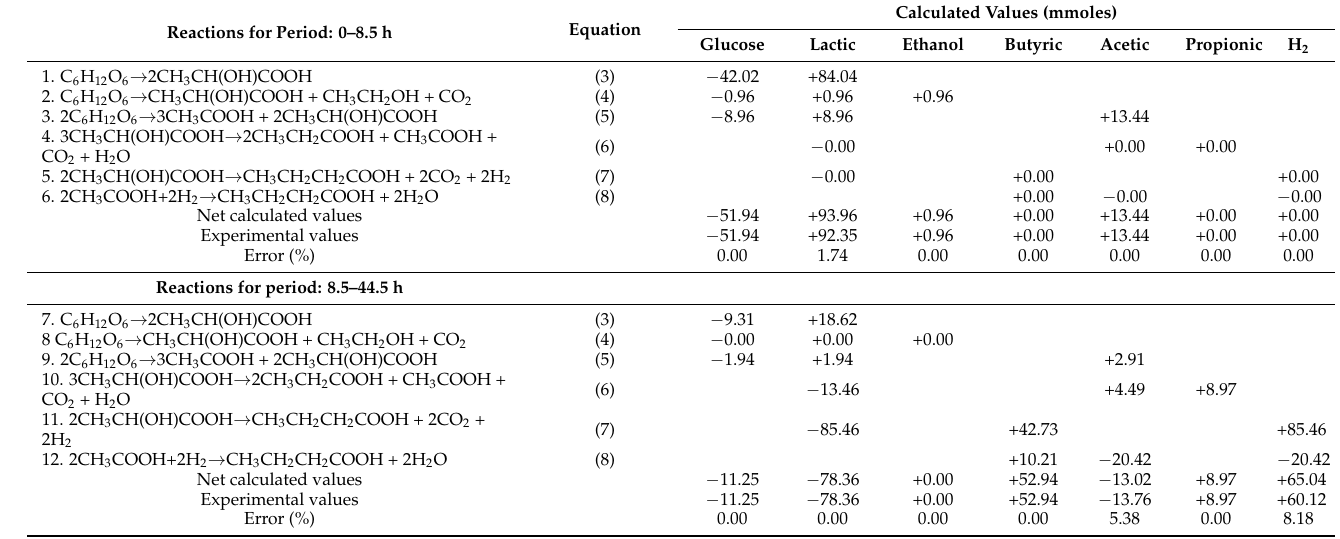
Table 4. Mass balances for hydrogen production using heat-treated inoculum at pH 5.5. Reactions for Period: 0–8.5